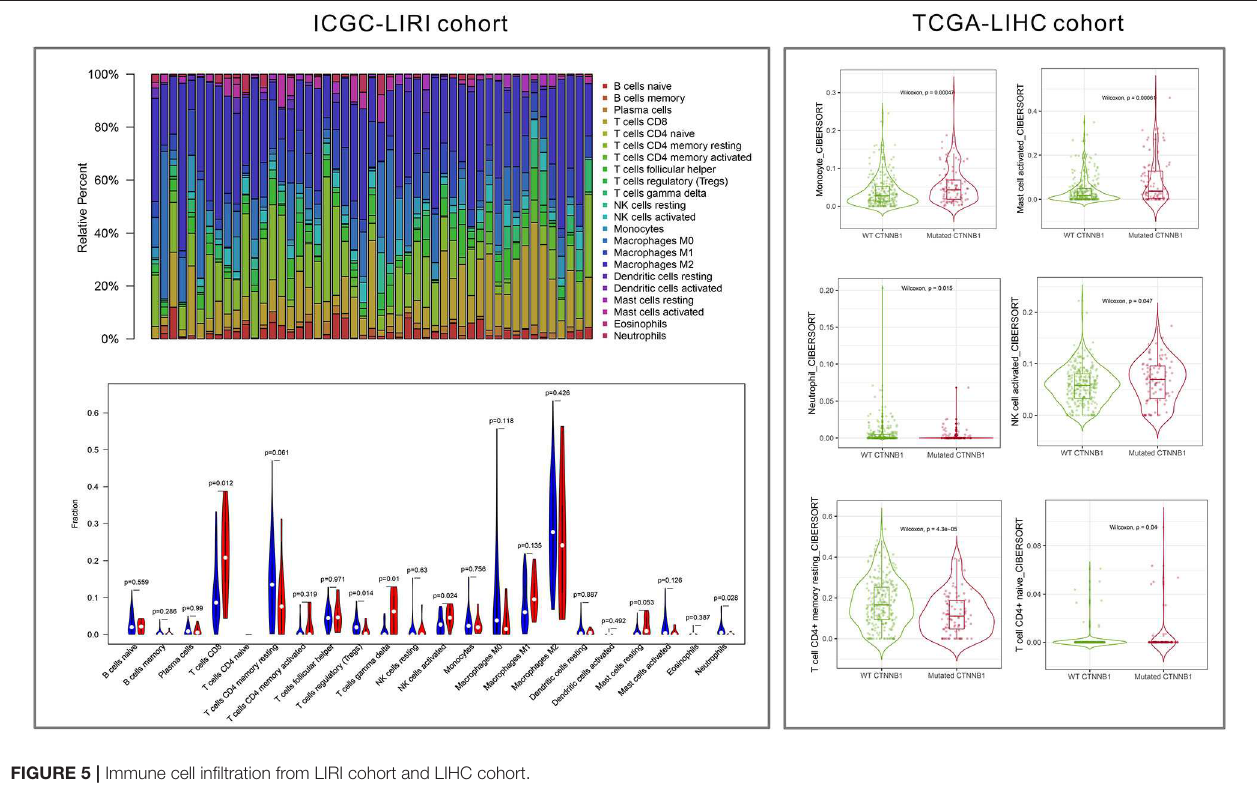
FIGURE 5 | Immune cell infiltration from LIRI cohort and LIHC cohort.